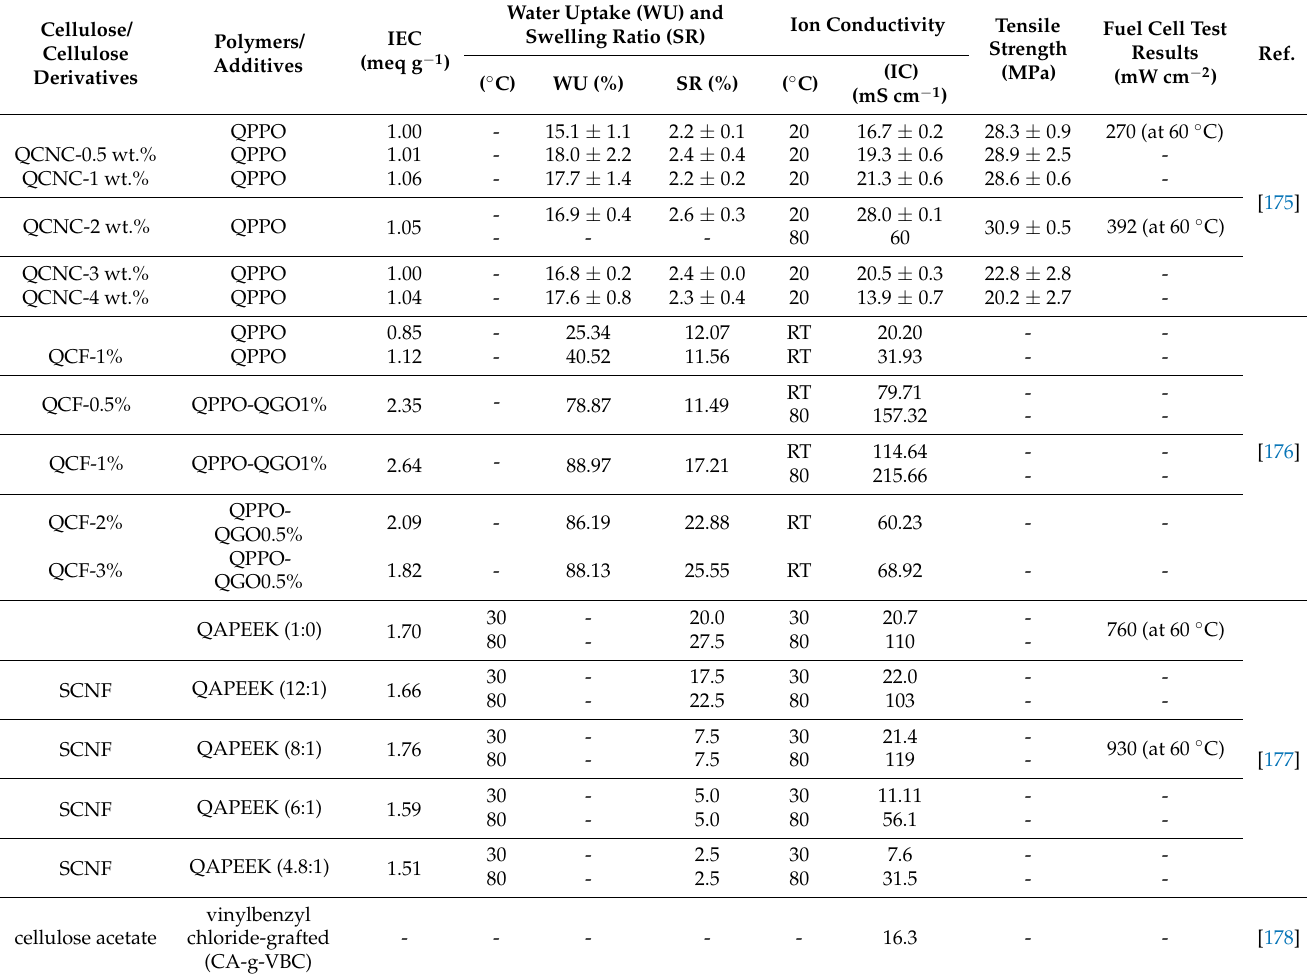
Table 2. Properties and performance results of modified cellulose-containing